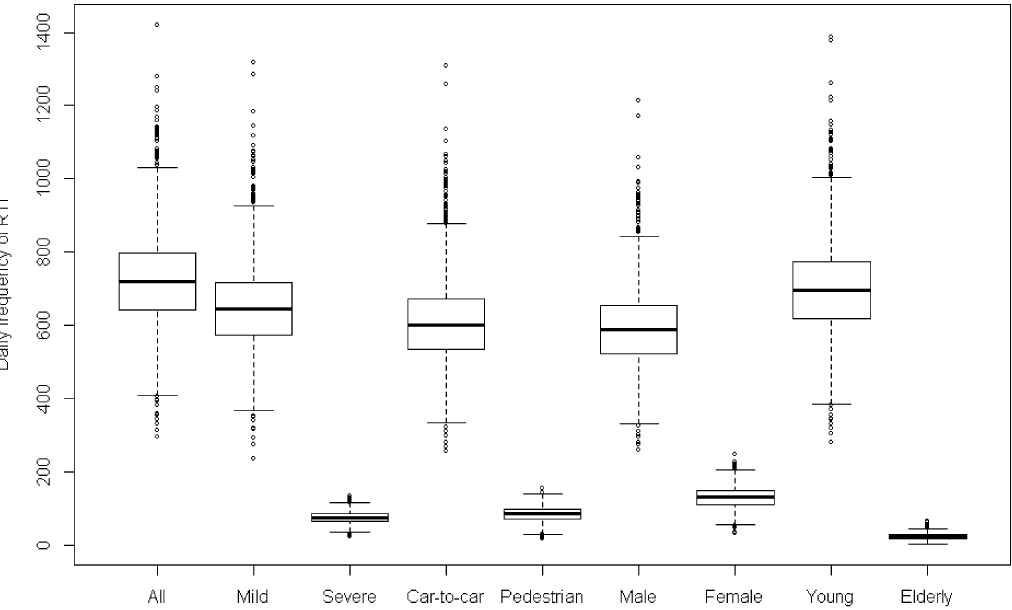
Figure 1. Daily frequency of road traf fi c injuries in Seoul from May 2007 to December 2011. “ All ” means all road traf fi c injuries (RTI); “ Severe ” means severe RTI which required ≥ 3 weeks of medical treatment, while “ Mild ” means mild RTI which required less than 3 weeks of treatment; “ Car-to-car ” is RTI from car-to-car accidents, while “ Pedestrian ” is RTI from car-to-pedestrian accidents; “ Male ” means RTI induced by male drivers, while “ Female ” means RTI induced by female drivers; “ Young ” is RTI induced by drivers younger than 65 years of age, while “ Elderly ” is RTI induced by the drivers aged 65 years and older.